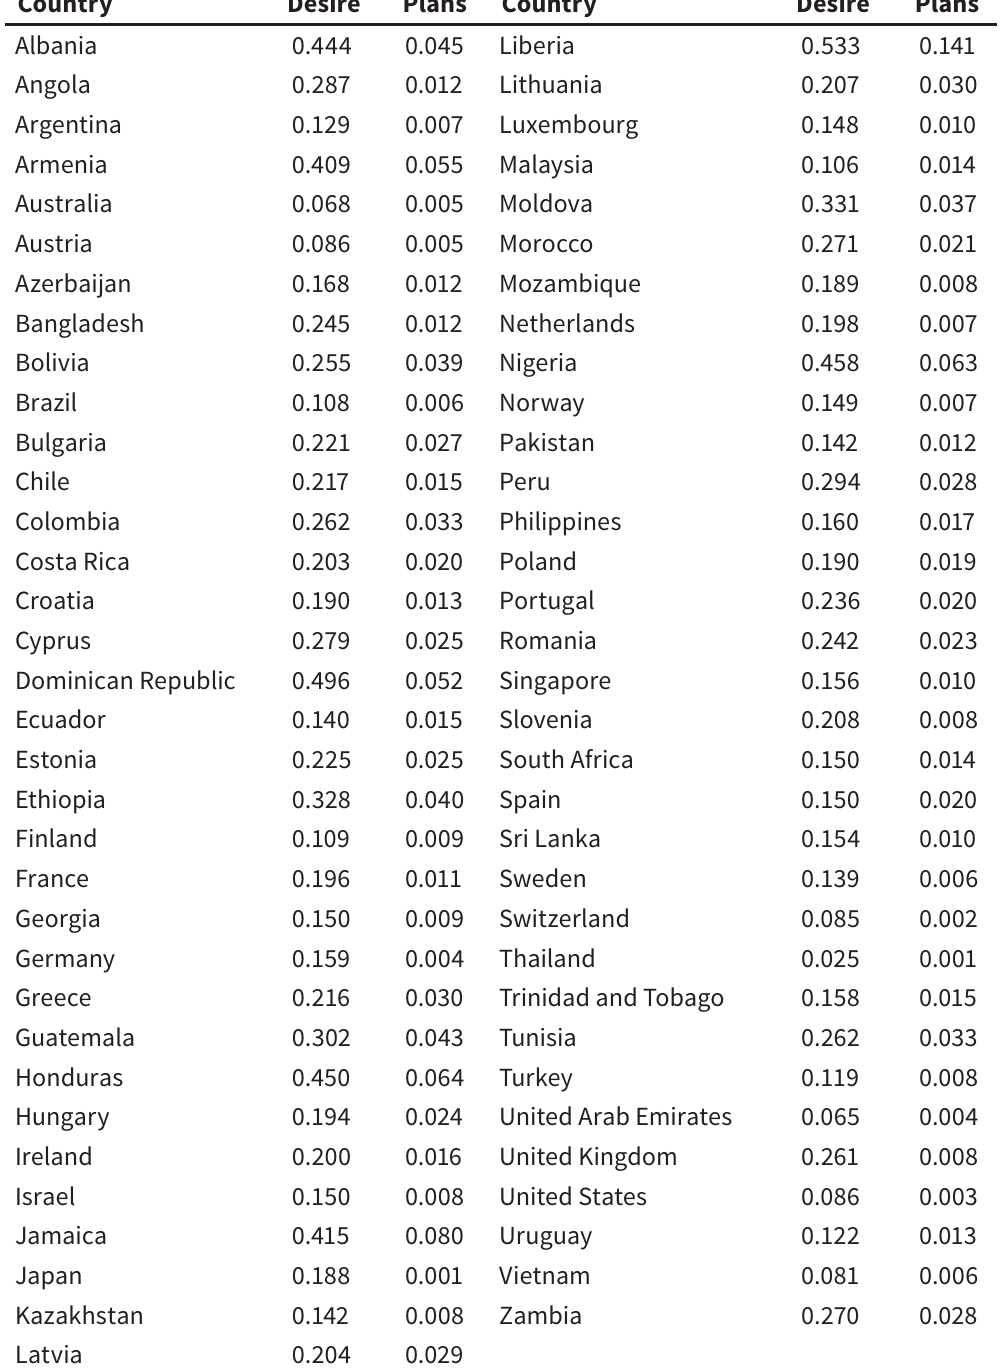
Table A2 Country coverage 2010–2014 and share of respondents with emigration